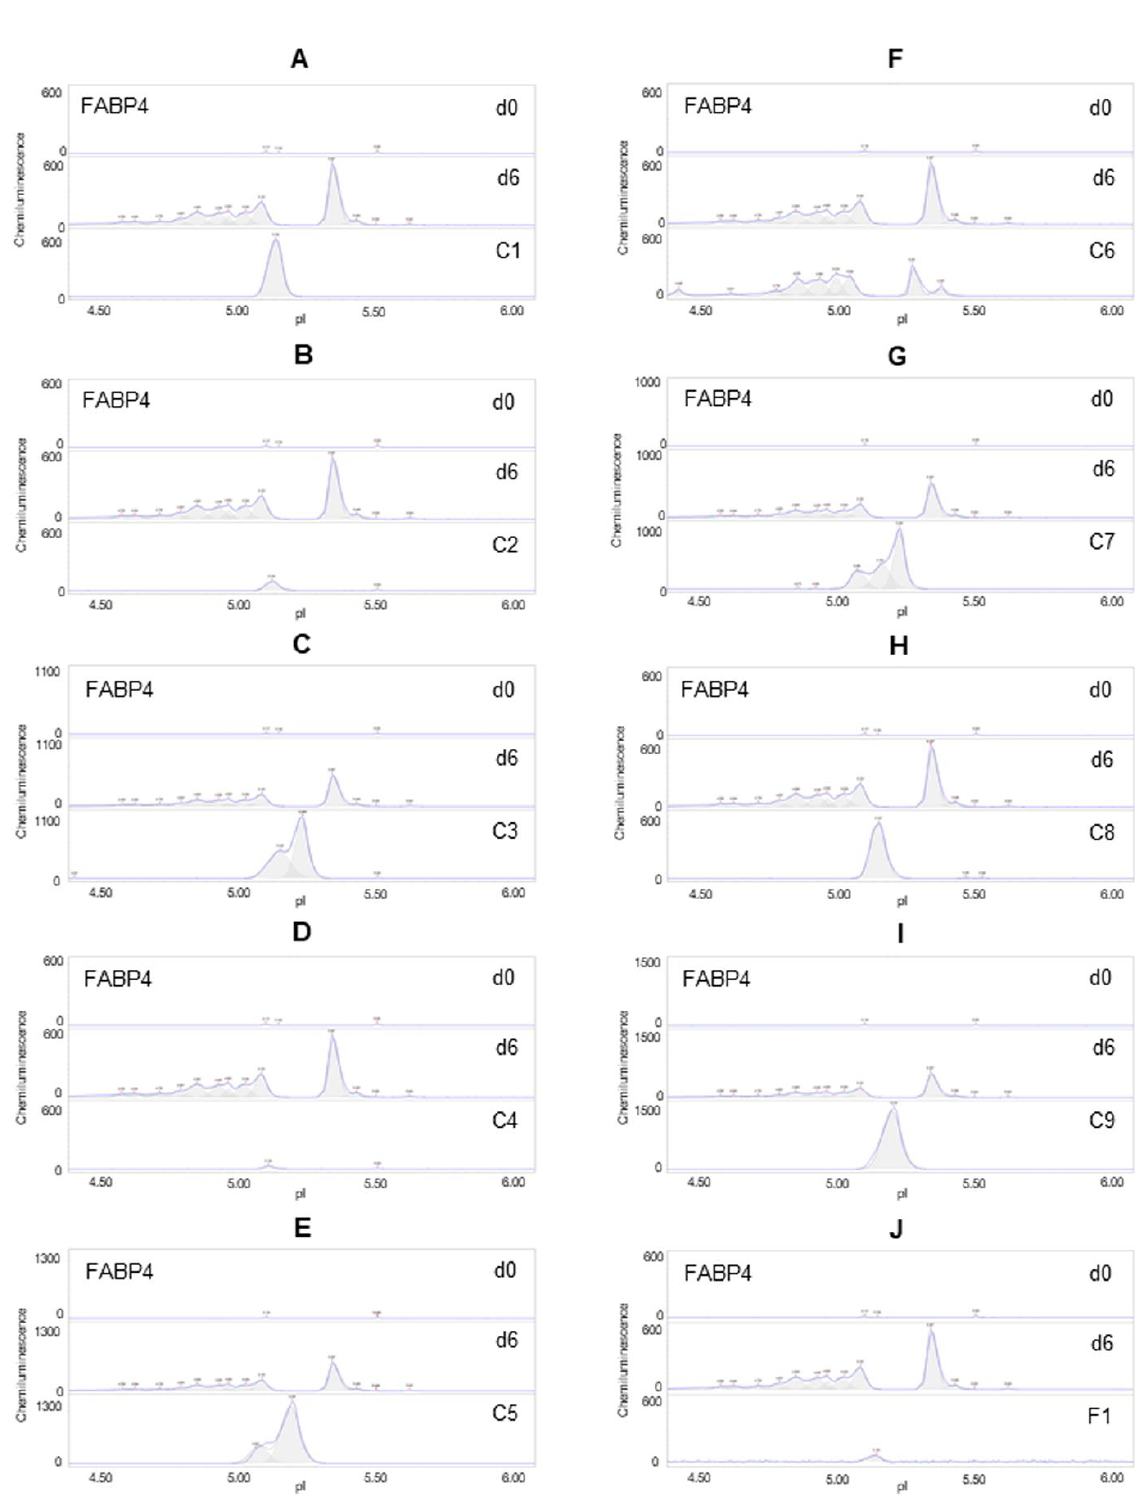
Figure 5. Suppression of FAB4 expression in differentiating preadipocytes. Expression level of FABP4 in preadipocytes on d0, d6 post-differentiation (d6), or d6 post-differentiation in the presence of ( A ) berberine (C1), ( B ) luteolin (C2), ( C ) resveratrol (C3), ( D ) fisetin (C4), ( E ) quercetin (C5), ( F ) fucoidan (C6), ( G ) EGCG (C7), ( H ) hesperidin (C8), ( I ) curcumin (C9), or ( J ) F1 composition. β -actin served as a loading control. The FABP4 protein post-translational modification profile was measured using capillary isoelectric focusing immunoassays.